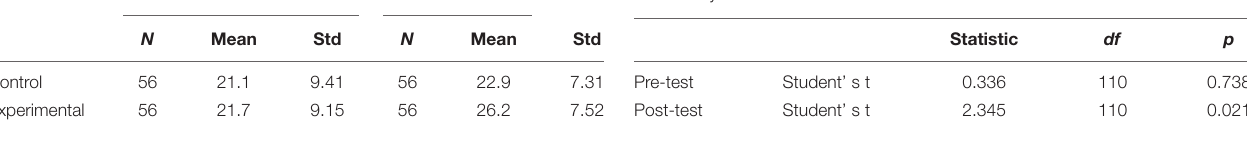
TABLE 7 | A comparison of score discrepancy between two groups by t -test